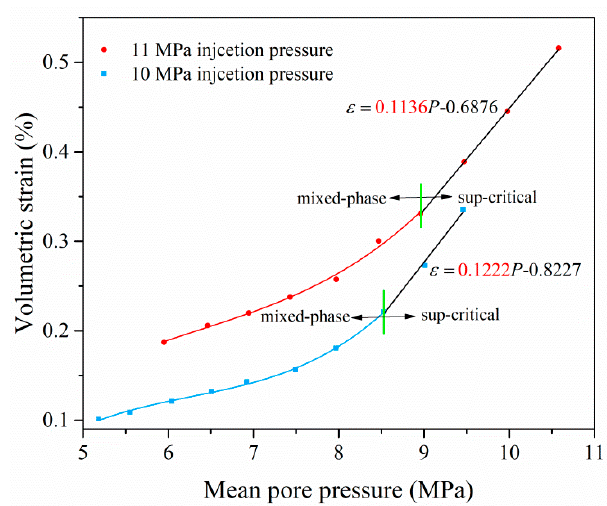
Figure 13. Variation of the volumetric strain versus the mean pore pressure (the mean of upstream and downstream pressures) of mixed-phase CO 2 at 20 MPa confining pressures.